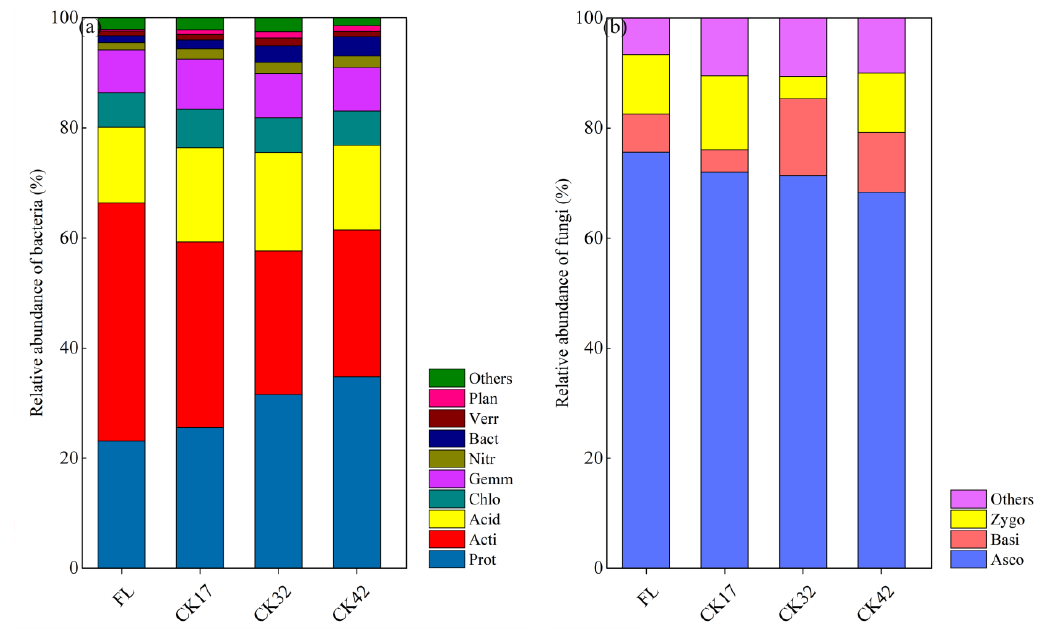
Figure 4. Relative abundance of the dominant groups of soil bacterial ( a ) and fungal ( b ) communities at the phylum level. The data for the average relative abundances from three replicates were calculated as the ratio between the abundance of the sequence type and the total number of sequences.